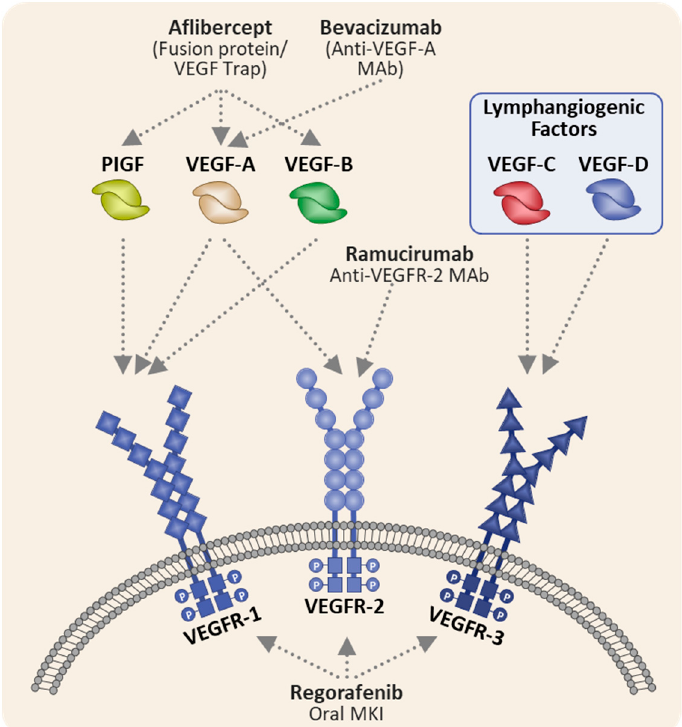
Figure 2. Mechanism of action of anti-VEGF agents in colorectal cancer (adapted from Clarke et al. [8]). mAB, monoclonal antibody; MKI, multikinase inhibitor; PlGF, placental growth factor; VEGF, vascular endothelial growth factor; VEGF-R, vascular endothelial growth factor receptor. VEGFR-1 is transcribed from the Fms-related receptor tyrosine kinase (FLT1) gene, VEGFR-2 from the Kinase Insert Domain Receptor (KDR) and VEGFR-3 from the FLT3 gene.